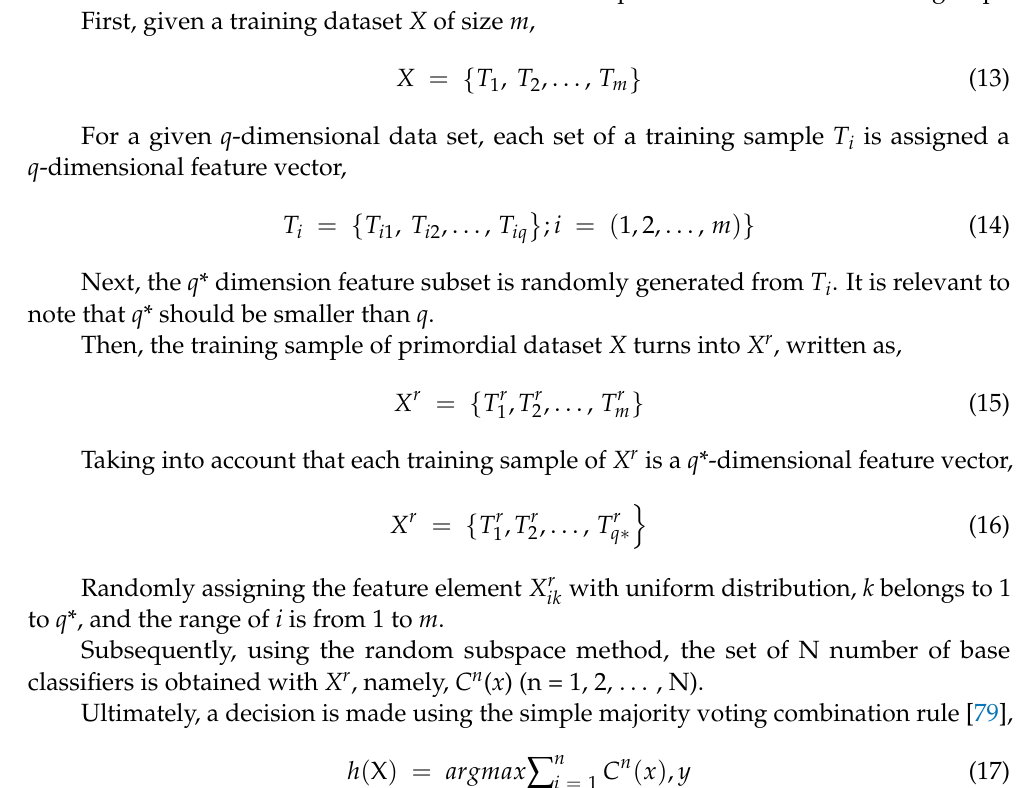
Table 3. Spatial relationship between conditioning factors and historical landslides using FR method.